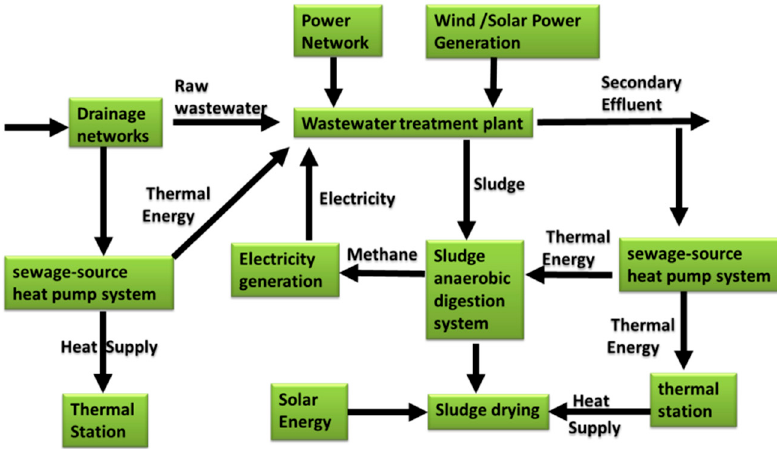
Figure 3. Energy utilization diagram of a wastewater treatment plant.